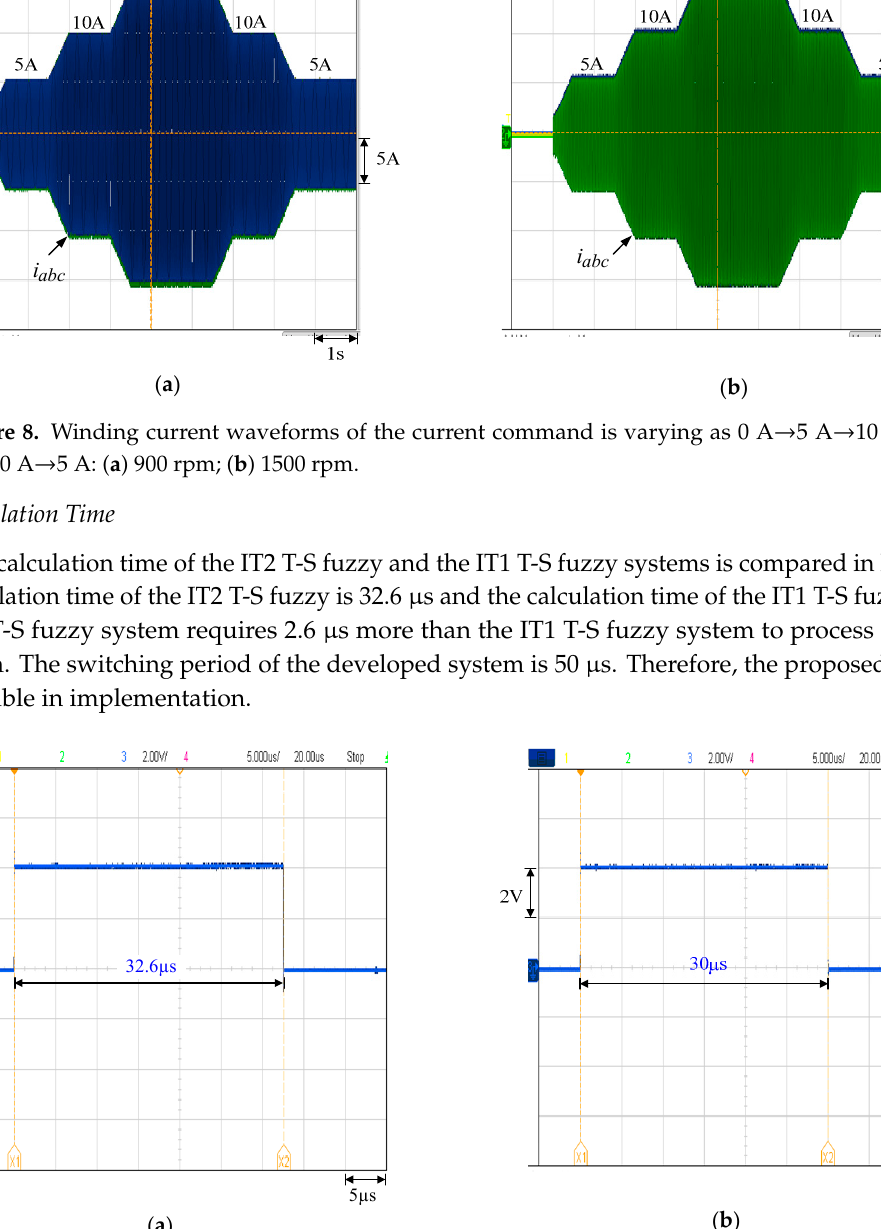
Figure 7. Winding current waveforms of the current command goes from zero to a constant value at